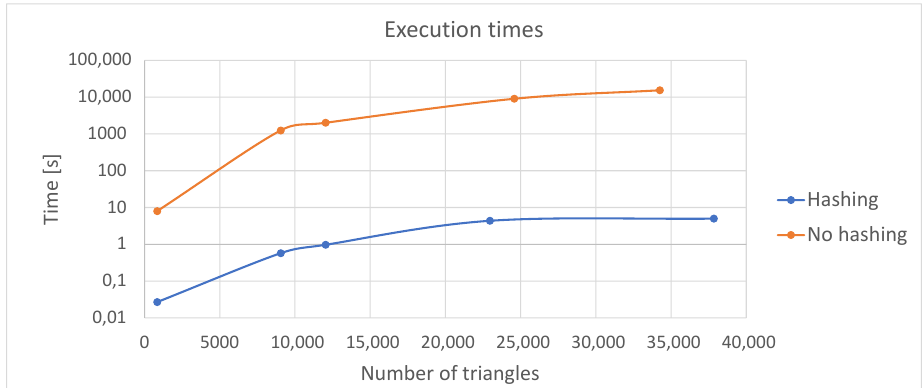
Figure 25. Execution times for B-Rep construction with and without previous spatial